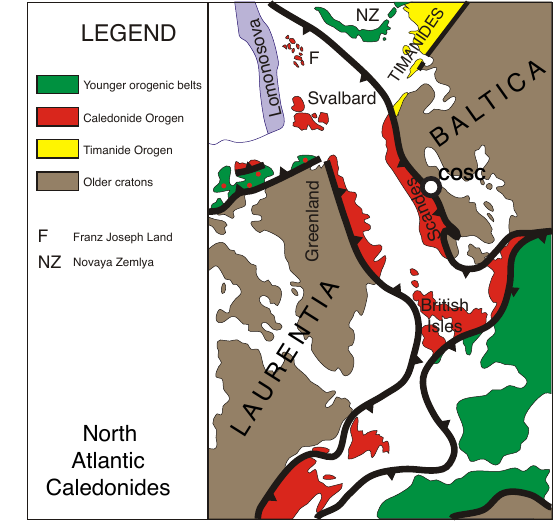
Figure 1. The Caledonides prior to opening of the North Atlantic Ocean. Modified from Lorenz et al. (2012).